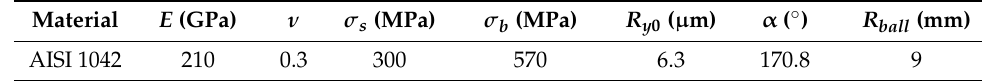
Table 1. Mechanical properties and geometric parameters of AISI